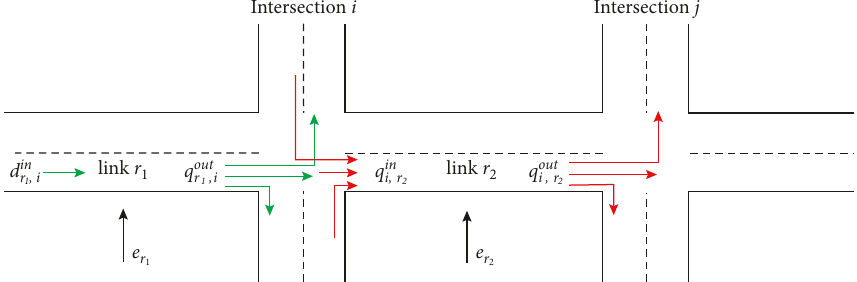
Figure 4: Traffic flow dynamics in links r